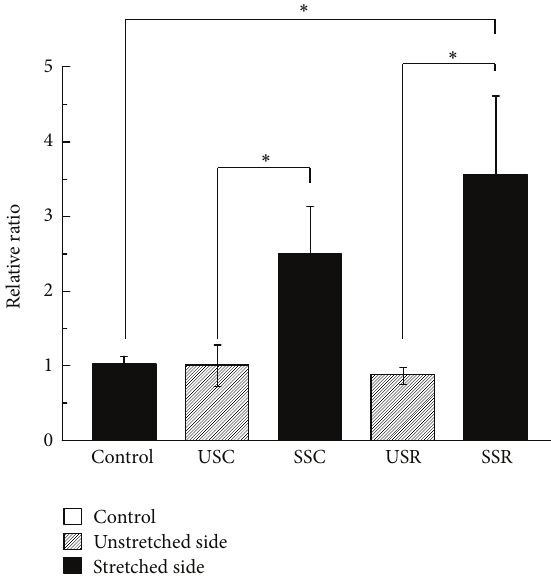
Figure 2: Myogenin mRNA expression. Relative ratio of myogenin mRNA expression induced under different stretching conditions (mean ± SE). The open bar shows the control group; shaded bars denote the unstretched side of continuous stretching and repetitive stretching; and filled bars denote the stretched side of continuous stretching and repetitive stretching. Significant differences were displayed ( ∗ 𝑃 < 0.05 ).